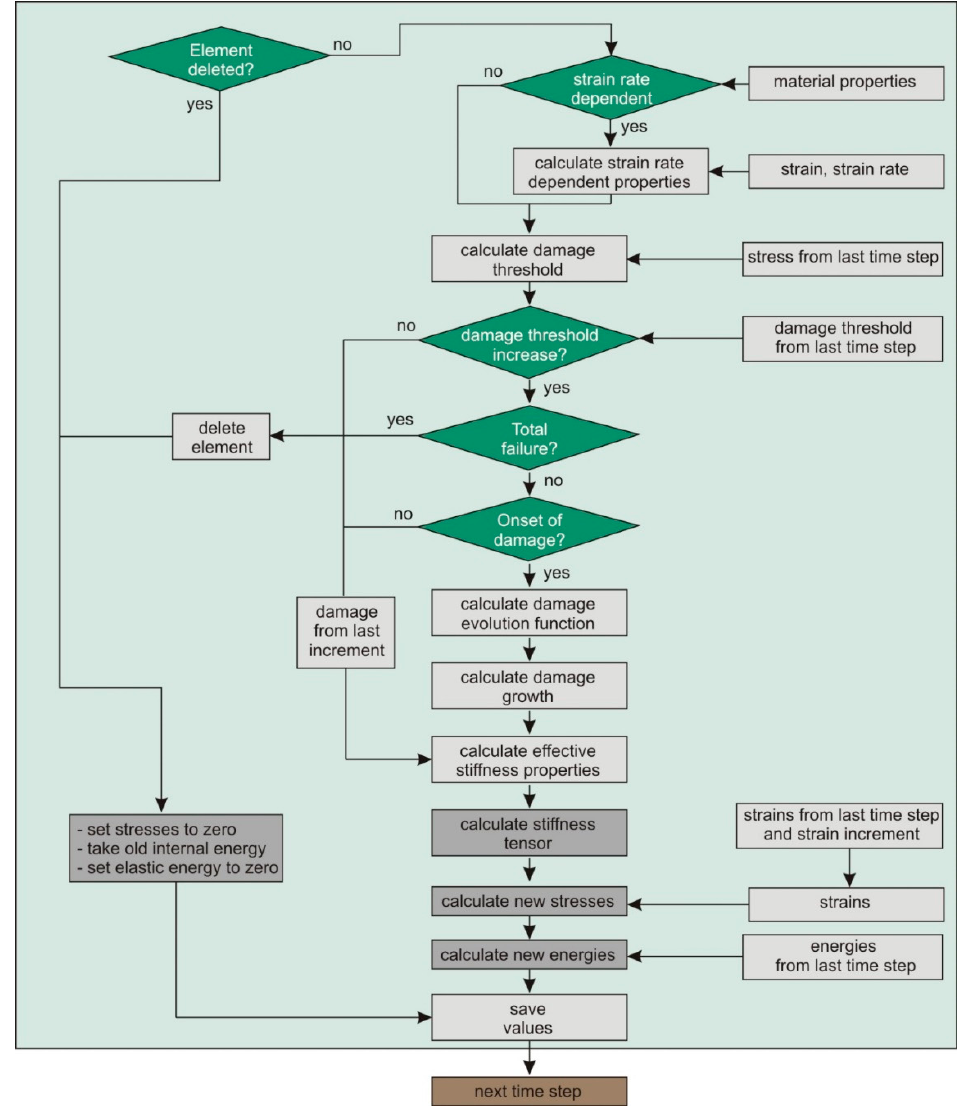
Figure 7. Flowchart of the VUMAT damage calculation within one time step.